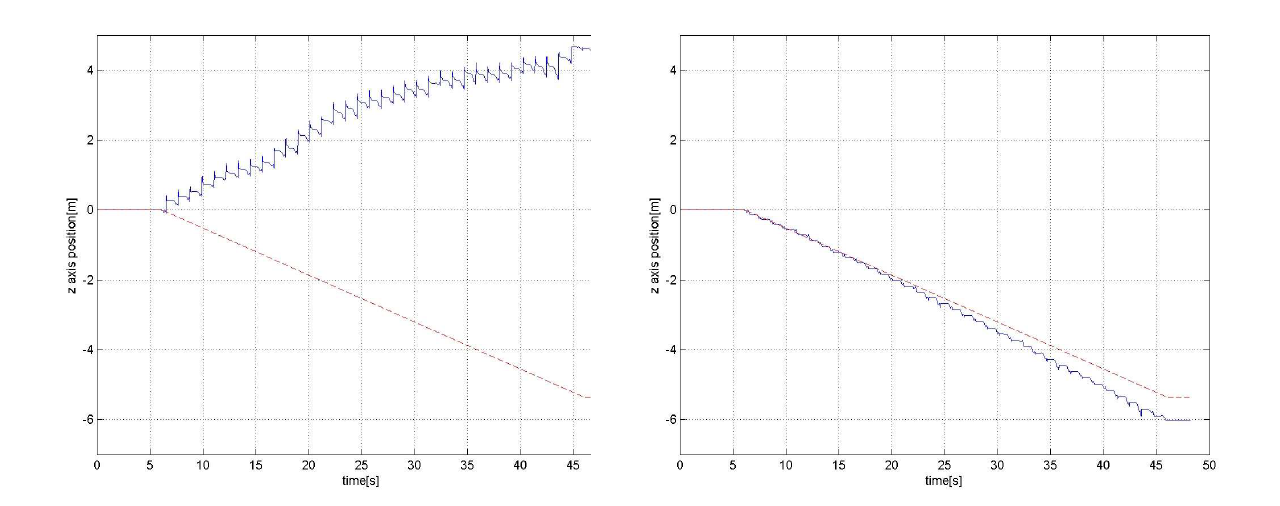
Figure 10. z axis position estimation for road C without (left) and with (right) the proposed height compensation